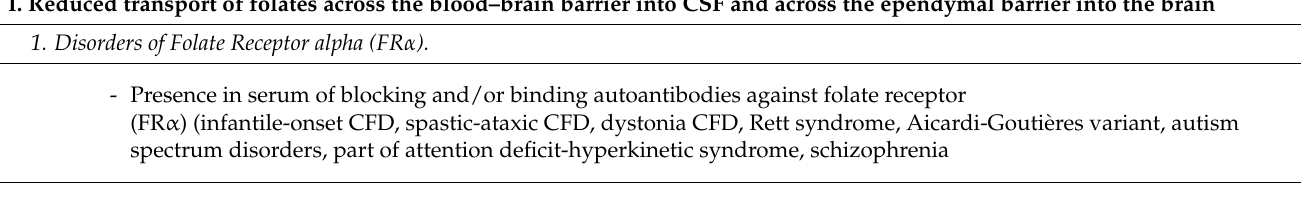
Table 1. Five potential mechanisms underlying